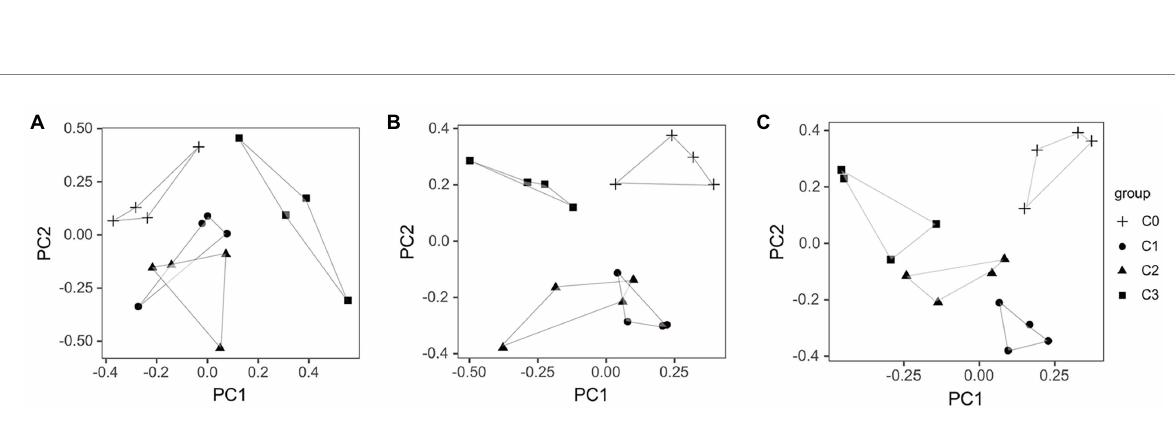
FIGURE 7 Principal component analysis (PCA) of zebrafish gut microbiota at phylum (A) , genus (B) , and species (C) levels. C0, C1, C2, and C3 refer to 0, 6, 9, and 18 μ g/l of AVH-AgNPs,